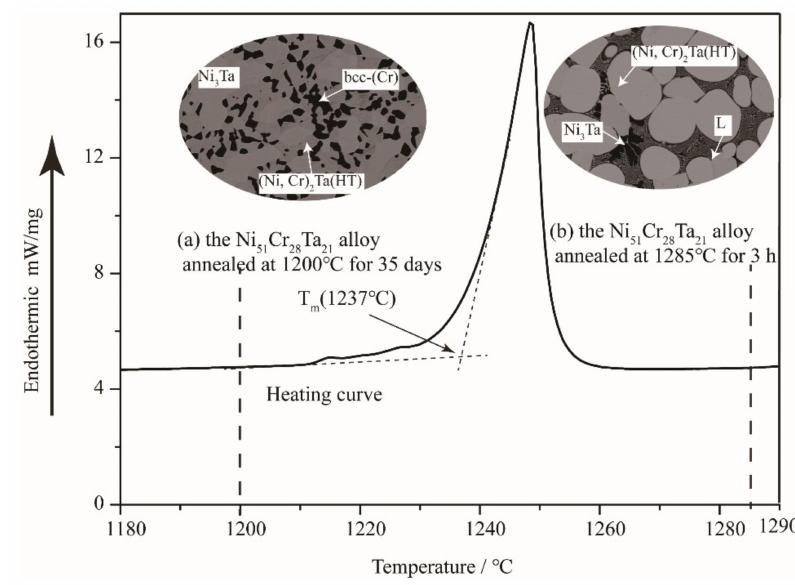
Figure 8. The heating curve of the Ni 51 Cr 28 Ta 21 alloy and microstructure annealed at ( a ) 1200 ◦ C for 35 days; ( b ) 1285 ◦ C for 3